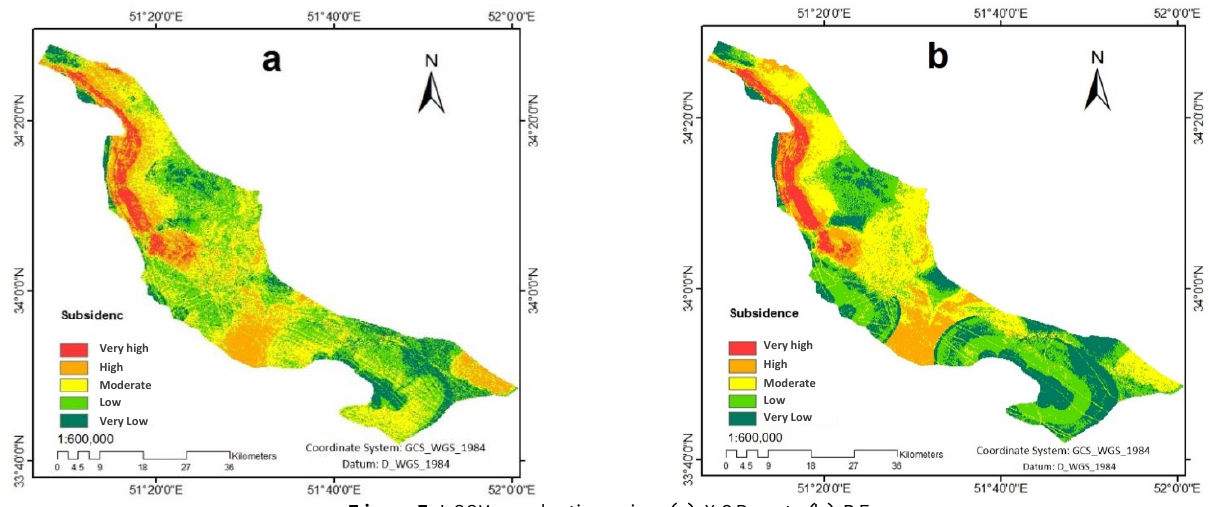
Figure 7. LSSM production using: (a). XGBoost, (b).